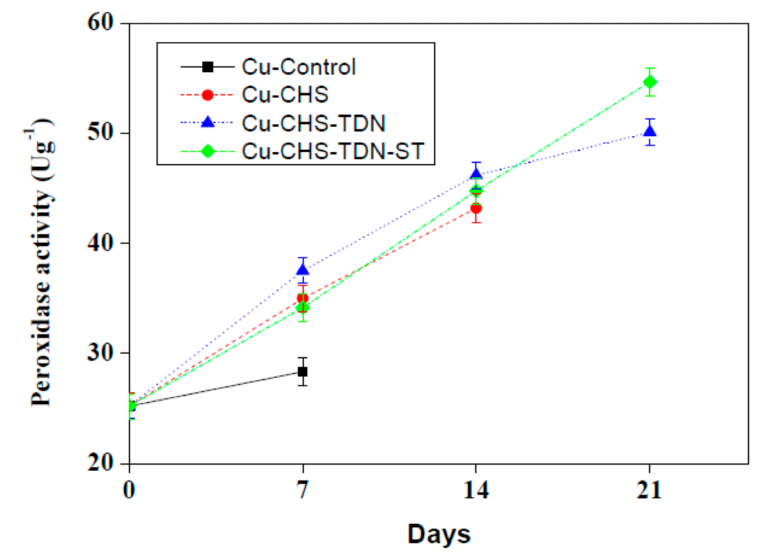
Figure 6. Effect of coating treatments on peroxidase enzyme